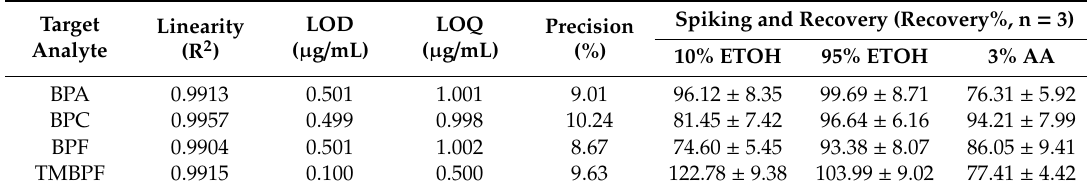
Table 3. Analytical performance of developed method for bisphenol monomer